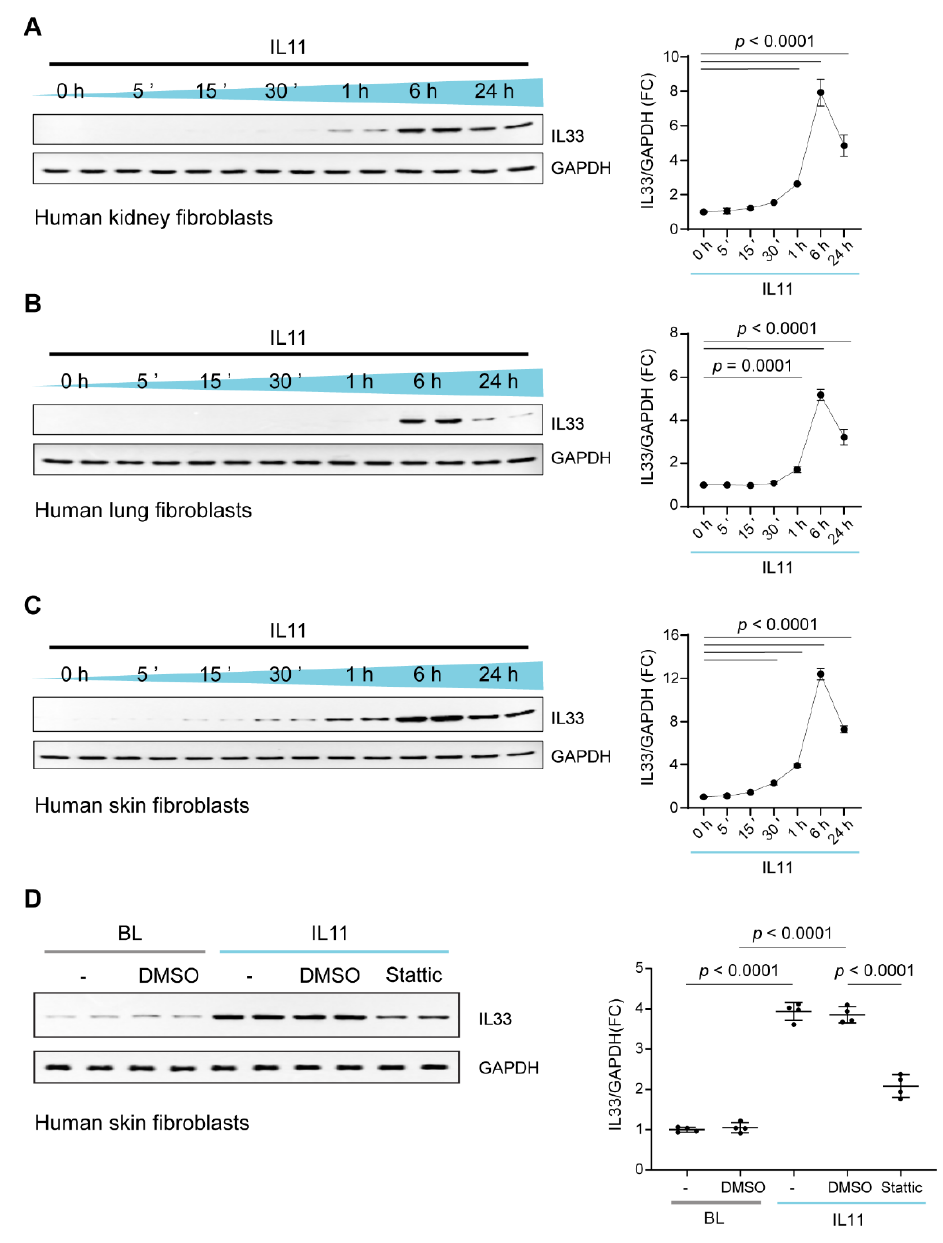
Figure 4. IL11 stimulates IL33 upregulation in kidney, skin, and lung fibroblasts. WB and densitome- try analyses of IL33 relative to GAPDH expression in ( A ) HKFs, ( B ) HLFs and ( C ) HSFs following IL11 (10 ng/mL) stimulation for 5 m, 15 m, 30 m, 1 h, 6 h and 24 h and in ( D ) basal (BL) and IL11-stimulated HSFs in the presence of DMSO or Stattic (2.5 µ M) or U0126 (MEK inhibitor, 10 µ M) for 1 h; data are shown as mean ± SD (n = 4 biological replicates). ( A – C ) One-way ANOVA with Dunnett’s correction; ( D ) one-way ANOVA with Tukey’s correction, FC: Fold